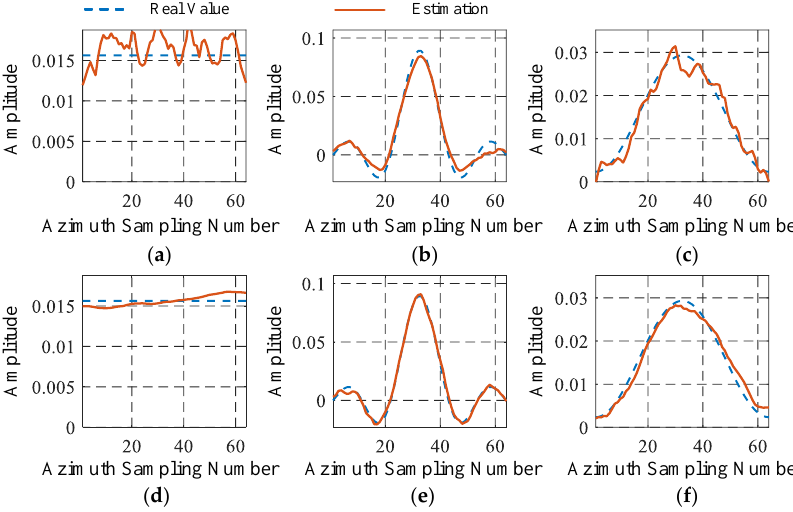
Figure 8. The comparison of the estimations from different methods (SNR = 0 dB). ( a ) Solution of (13) for the constant amplitude function. ( b ) Solution of (13) for the Sinc-like amplitude function. ( c ) Solution of (13) for the hamming-window amplitude function. ( d ) IRWTR solution for the constant amplitude function. ( e ) IRWTR solution for the Sinc-like amplitude function. ( f ) IRWTR solution for the hamming-window amplitude function.